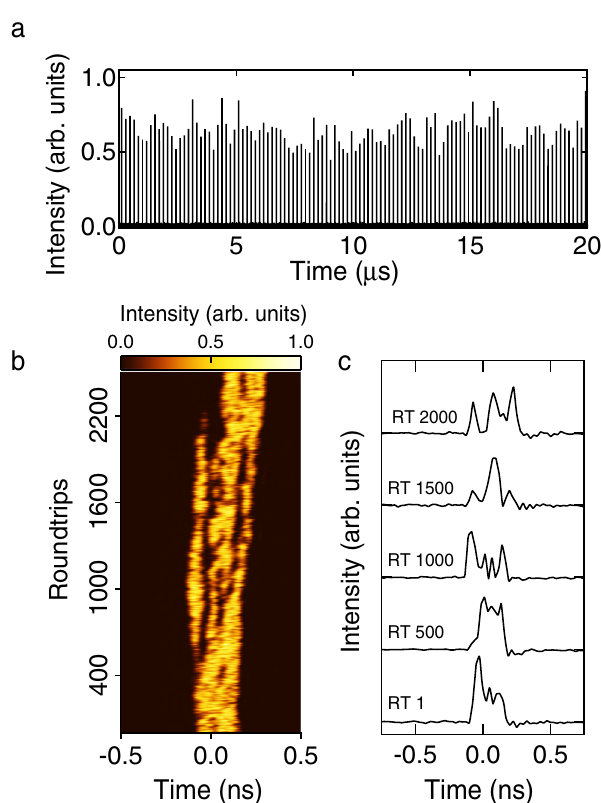
Fig. 5 Photodiode characterisation results after the EDF and before injection in the HNLF. a Measured pulse train plotted over a 20 μ s time span. b False-colour representation of the temporal evolution of the pulse envelope over 2500 roundtrips. c Temporal intensity pro fi les at roundtrip (RT) 1, 500, 1000, 1500 and